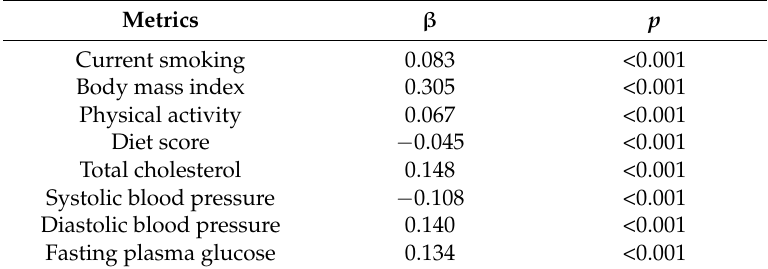
Table 2. Multiple linear regression on the association between each CVH metric and AIP a .